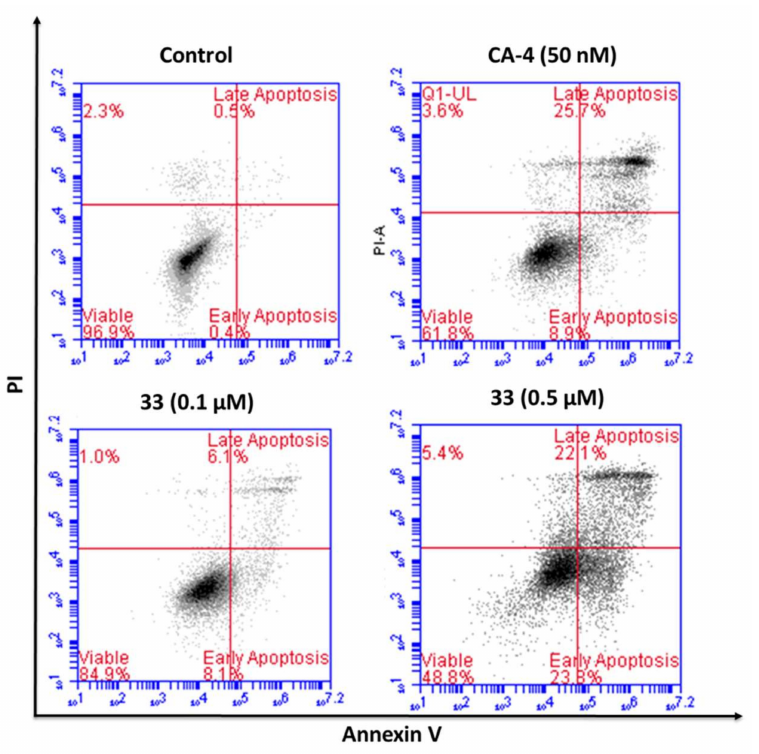
Figure 5. Compound 33 induces apoptosis in MCF-7 breast cancer cells. MCF-7 breast cancer cells were treated with 33 (0.1 and 0.5 µ M), CA-4 (50 nM) or vehicle control (0.1% ethanol ( v / v )) for 48 h. The percentage of apoptotic cells was determined by staining with Annexin V–FITC and PI. In each panel, the lower left quadrant shows cells that are negative for both PI and Annexin V–FITC, and the upper left shows cells that are only negative PI, which are necrotic. The lower right quadrant shows Annexin-positive cells which are in the early apoptotic stage, and the upper right shows both Annexin- and PI-positive cells, which are in late